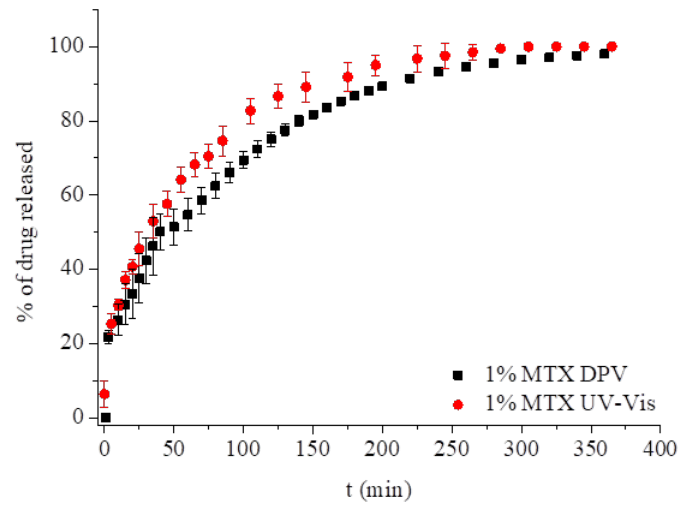
Figure 5. Release profiles of MTX from LCPs measured with UV-Vis spectroscopy and differential pulse voltammetry at pH 7.4 at 25 °C.